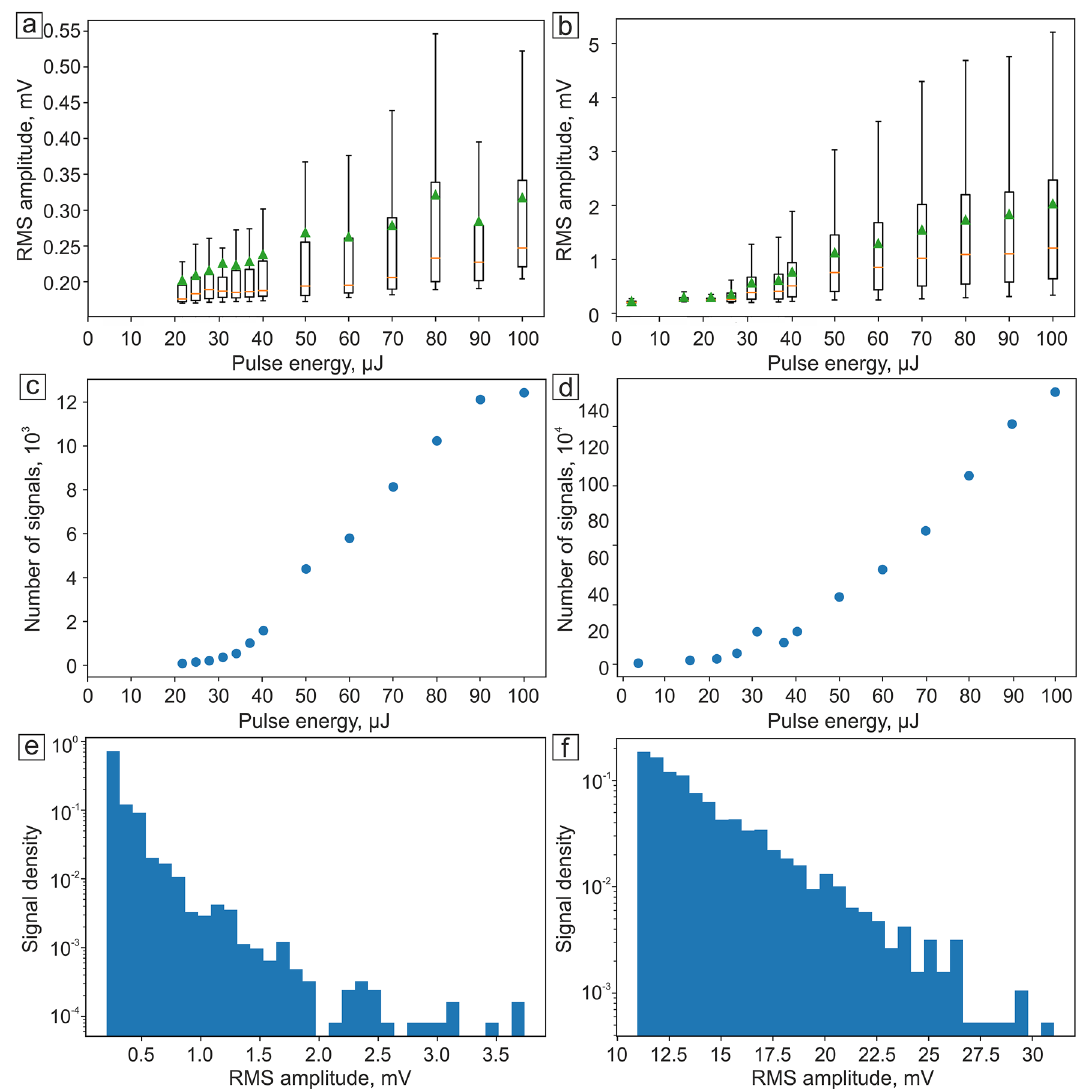
Figure 7. RMS amplitude of PA signal dependence on laser pulse energy for ( a ) B16F10 cells and ( b ) melanoma cell phantoms; dependence of number of signals on laser pulse energy for ( c ) B16F10 and ( d ) melanoma cell phantoms; signal density of ( e ) B16F10 and ( f ) melanoma cell phantoms for 50 µJ pulse energy. Orange lines on graphs ( a ), ( b ) represent median values, while green triangles reflect the mean